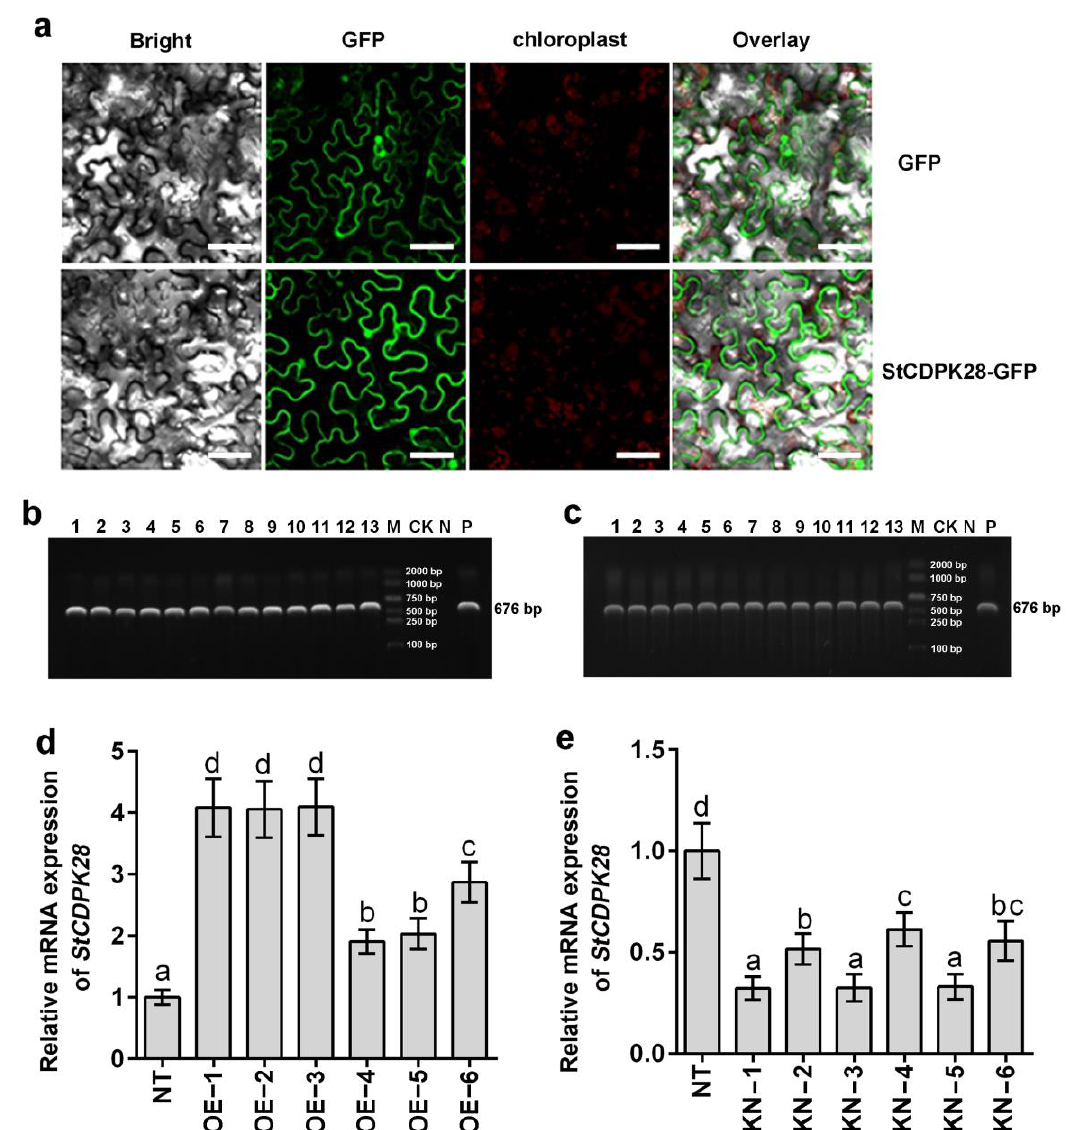
Figure 4. Subcellular localization of the StCDPK28-GFP fusion protein and establishment of trans- genic potato plants overexpressing or underexpressing StCDPK28 . ( a ) Confocal microscopy pictures of Nicotiana tabacum cells transformed with a GFP - StCDPK28 construct using GFP as a control. Scale bars = 75 µ m. PCR products of NPTII (676 bp) showing the introduction of ( b ) StCDPK28 sequence into potato plant, as well as ( c ) amiStCDPK28 for StCDPK28 knockdown. ( d , e ) Expression profiling of StCDPK28 in 4-week-old potato leaves was analyzed by qRT-PCR with StEf1a as an internal control. Data are presented as the means ± standard deviation of nine replicates. The letters indicate significant differences according to one-way ANOVA corrected by Dunnett ( p <